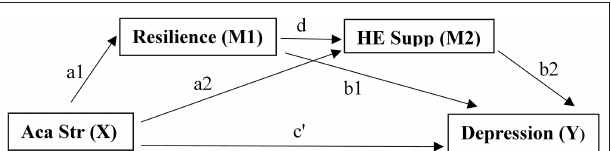
FIGURE 1 | Explanatory serial mediation model with hypothesised direct pathway, independent mediation pathways, and serial mediation pathway between academic stress, depression, resilience, and HE support. Aca Str, academic stress; HE Supp, higher education